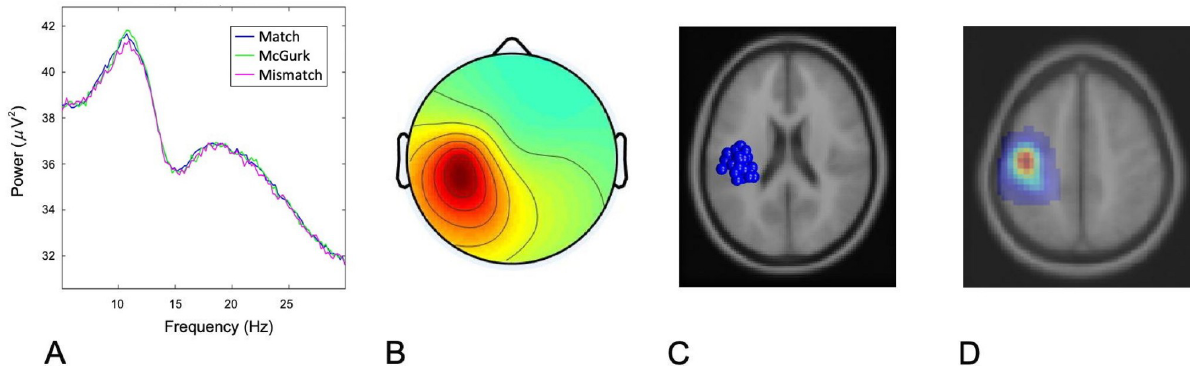
Fig 2. Cluster characteristics for left mu cluster. (A) Mean spectra for cluster components. (B) Mean scalp map for left hemisphere mu cluster. (C) ECD source localization estimates for contributing components. (D) Probabilistic dipole density, demonstrating maximal cluster localization.